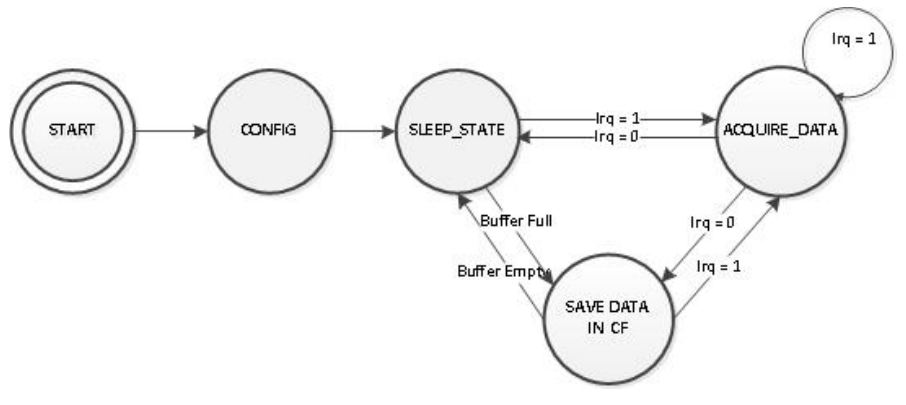
Figure 19. OBS state machine.